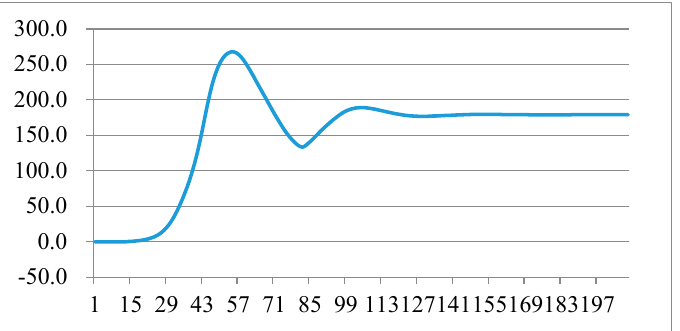
Figure 10. Phase-locked angle test when the angle suddenly changes by 179 degrees.